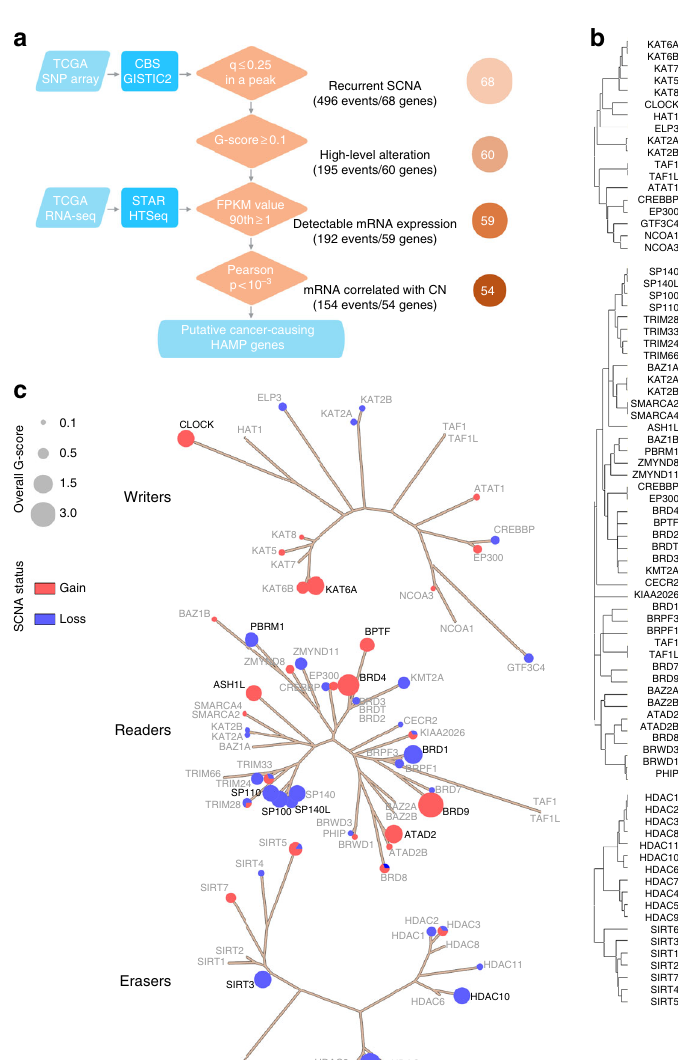
Fig. 1 Ubiquitous HAMP mRNA expression across cancers. a The heatmap shows the mRNA expression levels of HAMPs across cancers. The intensity of purple indicates the percentile (25th, 50th, 75th, and 90th) of the FPKM value of each HAMP in a given cancer type. The phylogenetic trees were generated by multiple sequence alignments of the full-length sequences of the proteins. b Summary of the overall mRNA expression of each HAMP across 33 cancer types. The intensity of purple indicates the number of cancer types in which a given HAMP was de fi ned as detectable (the 90th FPKM value ≥ 1). Gray indicates the HAMPs with mRNA expression levels that are cancer type-speci fi c. The phylogenetic trees were generated by multiple sequence alignments of the full-length sequences of the proteins. c TCGA specimens were arranged in two dimensions based on the similarity of their HAMP expression pro fi les by the dimensionality reduction analysis t-SNE ( t -distributed stochastic neighbor embedding). Colors represent cancer types. The cancer types ( n = 33) and their color keys are listed based on tissue origin